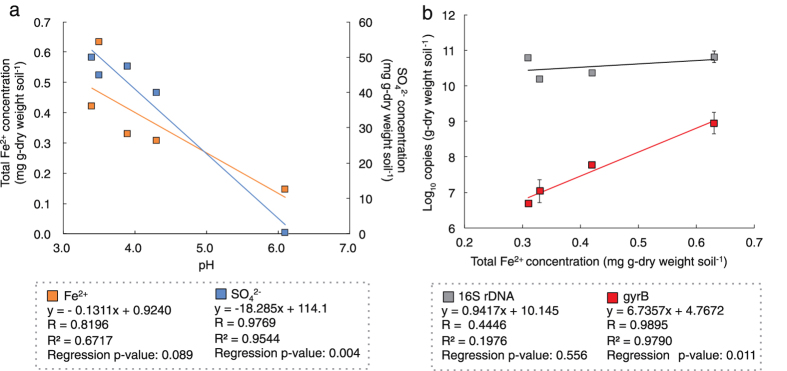
Relationships among chemical compositions and bacterial numbers.(a) Relationship between pH and SO42− (blue) or Fe2+ (orange) concentration and (b) Fe2+ concentration and copy number of bacterial 16S rRNA gene (grey) or L. ferrooxidans gyrB gene (red). Error bars, s.d. of triplicate results. Result of the statistical significance test (R, correlation coefficient; R2, determination coefficient of the regression model).